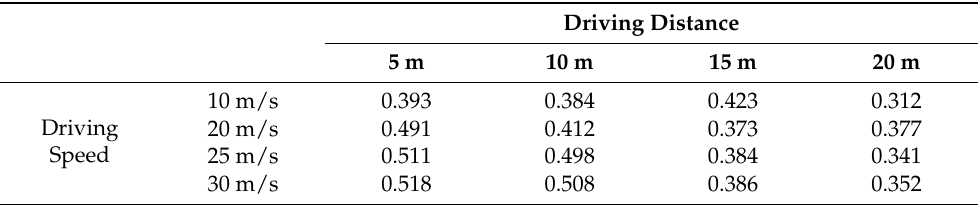
Figure 24. FFT results of the vehicle acceleration responses when driving from a 20 m offset distance with a speed of 10 m/s. Table 9. Acceleration amplitude for the 3 Hz component in the vehicle’s vibration.